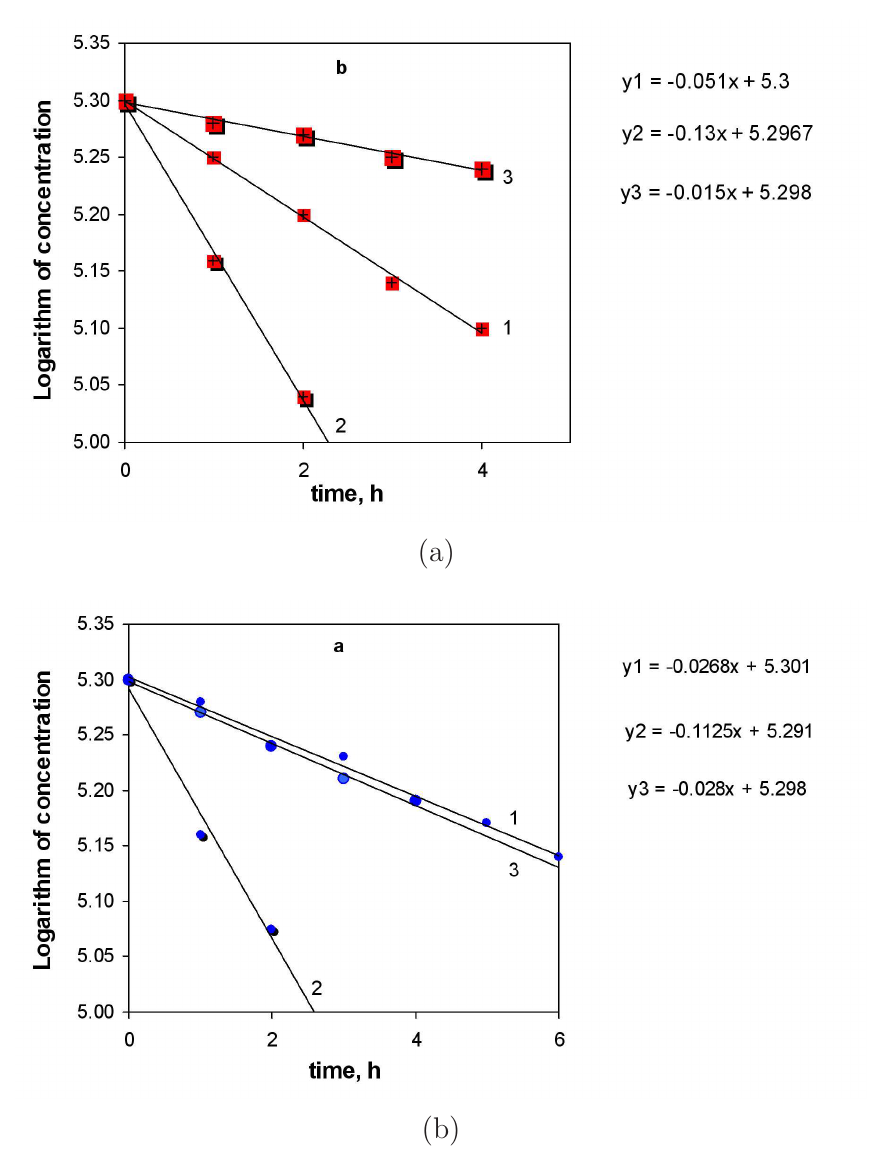
Fig. 4 Dependencies of ln C on time for catalase adsorption on: (a) activated carbon NORIT; (b) carbon black PM-100. The adsorption process was carried out at temperatures: 1) 4 ◦ C; 2) 24 ± 1 ◦ C; 3) 32 ◦ C; start concentration of the enzyme solution 200 µ M; pH =